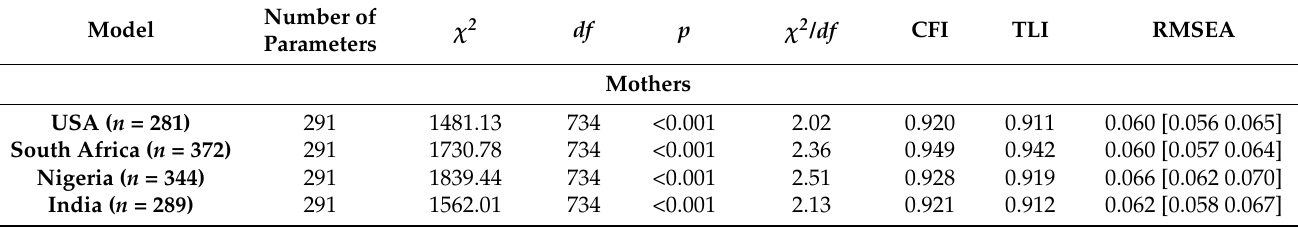
Table 2. CFA fit indices with separate ratings for fathers and mothers from the USA ( n = 259,